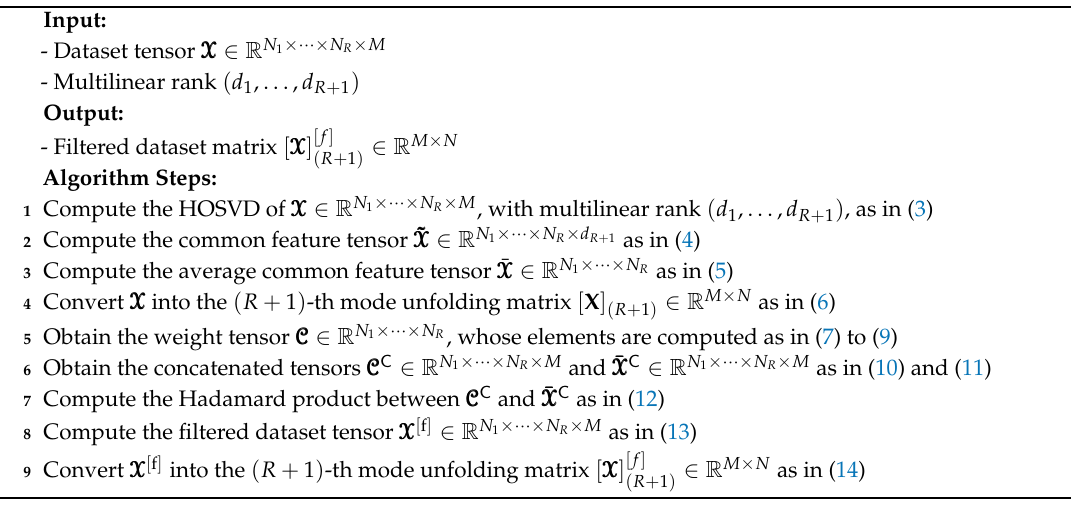
Algorithm 1: Proposed average common feature extraction technique for DDoS attack